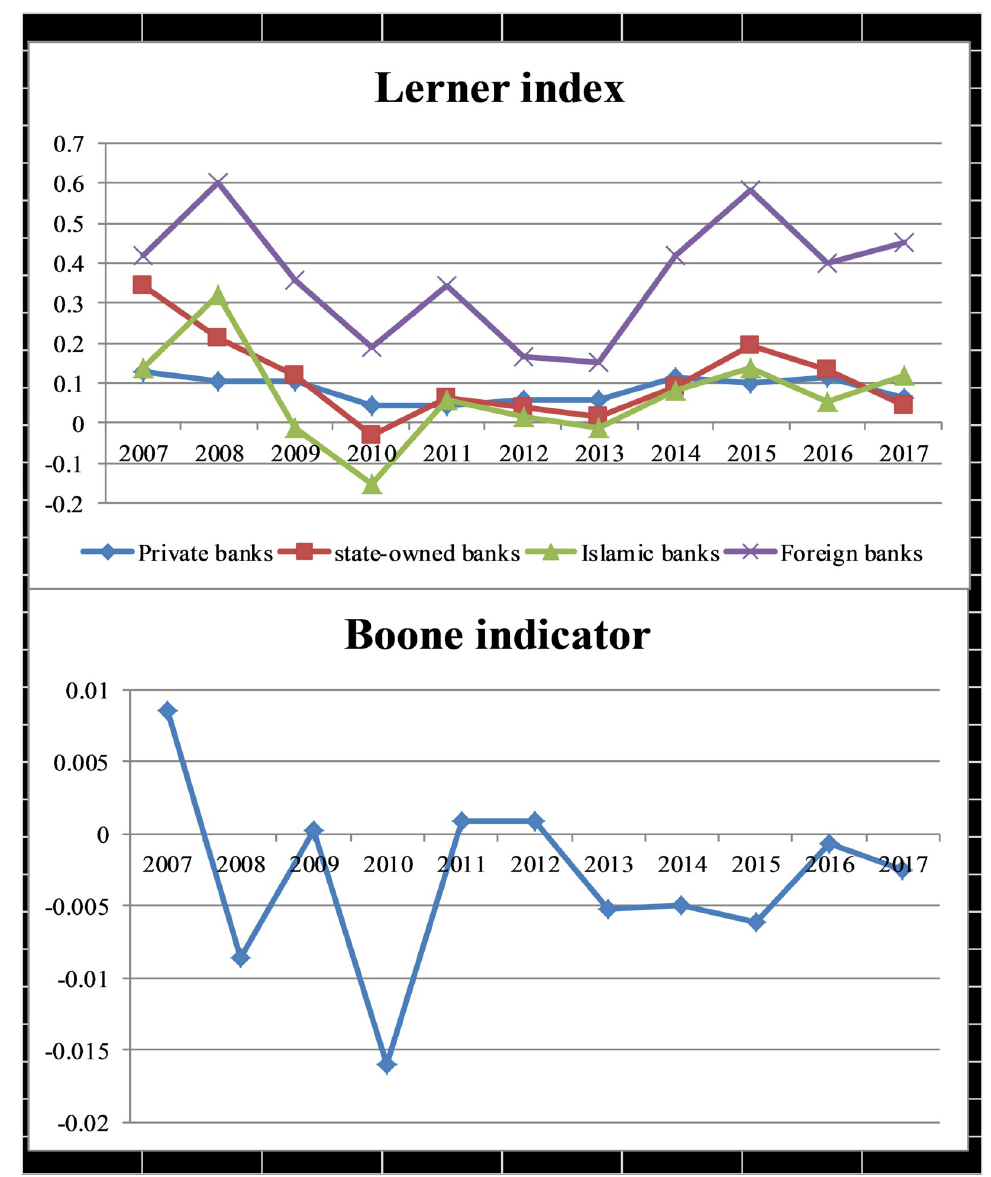
Fig 2. Competition indicators of Pakistani